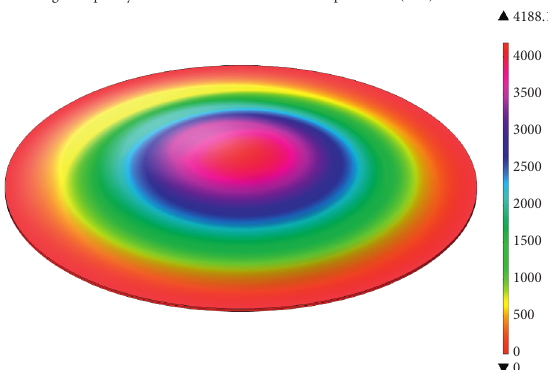
Figure 10: Modal analysis result of piezoelectric circular plate.